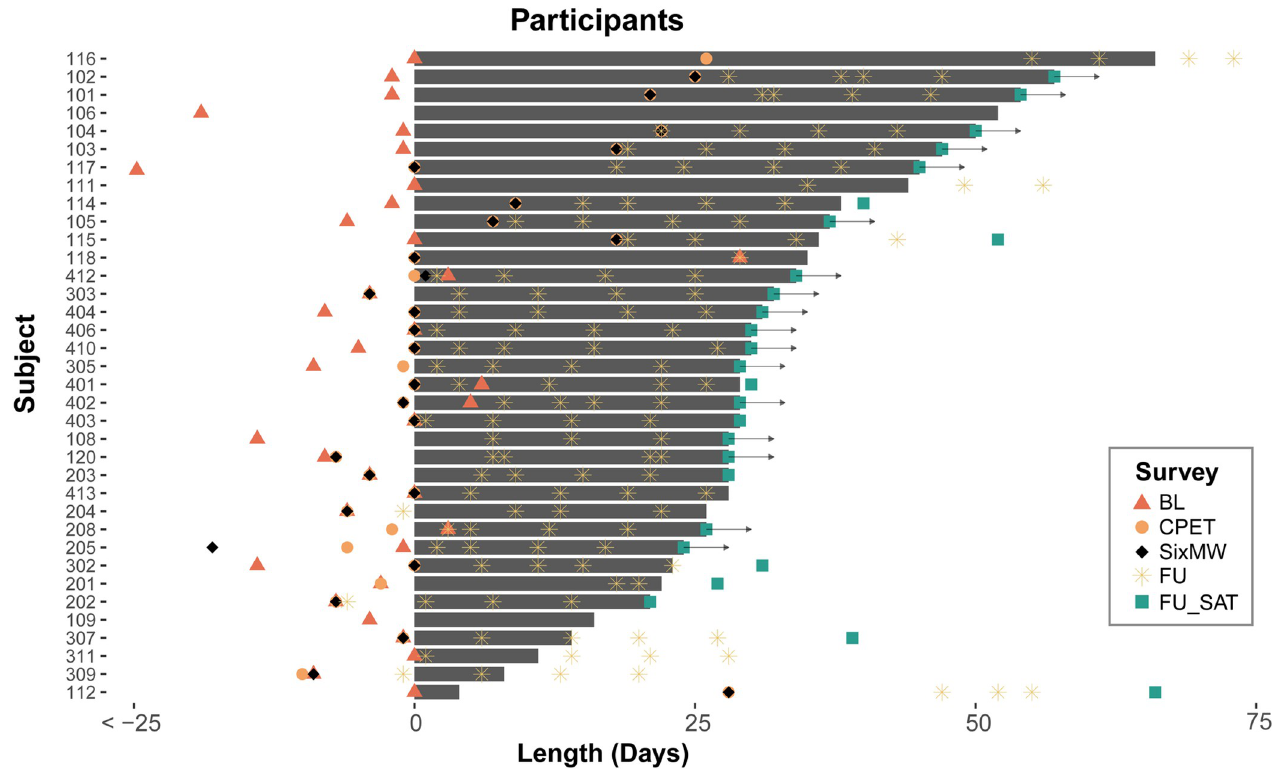
Fig 2. Swimmer’s plot of tracker data collection relative to survey instrument administration and baseline exercise physiology testing. Participants who continued wearing trackers following formal completion of the study period are marked with arrows (BL: Baseline Survey, CPET: Cardiopulmonary Exercise Testing, SixMW: Six Minute Walk Test, FU: Follow Up Survey, FU_SAT: Follow Up Satisfaction Survey). Delays from enrollment to acquisition of sensor data were generally related to timing of the start of chemotherapy and baseline